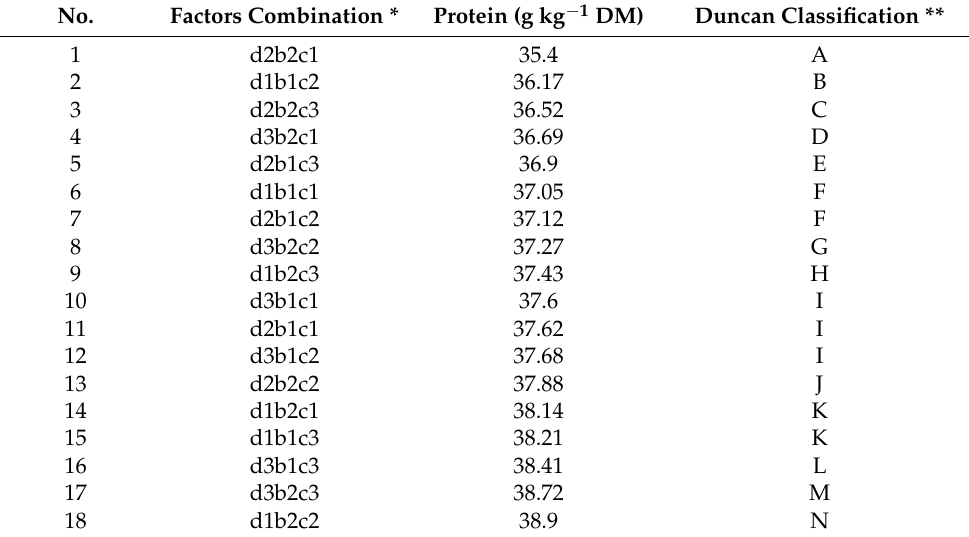
Table 7. Synthesis of soybean protein content (g kg − 1 DM) comparisons by technological factors (Duncan classification of the average values for